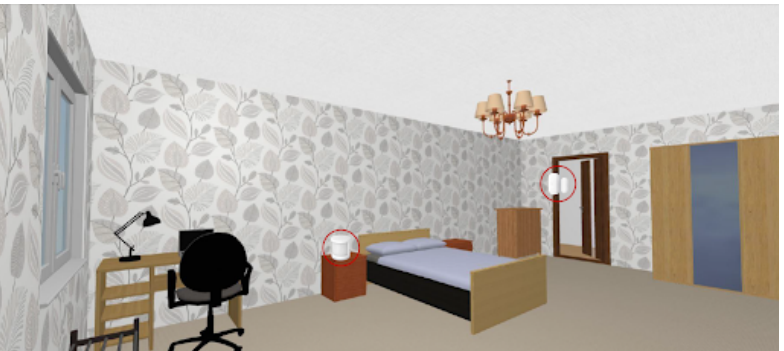
Figure 27. Sensors in the